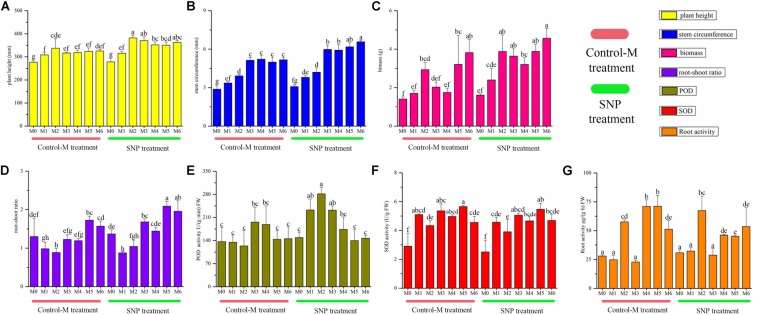
Growth indicators of inoculated C. illinoinensis seedlings with or without exogenous NO (100 μmol/L SNP) at different growth months after inoculation. (A) plant height, (B) stem circumference, (C) biomass, (D) root-shoot ratio, (E) POD activity in roots, (F) SOD activity in roots, (G) root activity. Each value is the mean of three replicates (±SD) in a treatment. Different lowercase letters indicate significant differences between all of the treatments in different months after inoculation (P < 0.05 in the LSD test of ANOVA). Control-M treatment: inoculated seedlings that did not receive 100 μmol/L SNP; SNP treatment: inoculated seedlings treated with 100 μmol/L SNP. M0, M1, M2, M3, M4, M5, and M6 represent seedlings harvested at month 0, 1, 2, 3, 4, 5, and 6, respectively, after T. indicum inoculation.